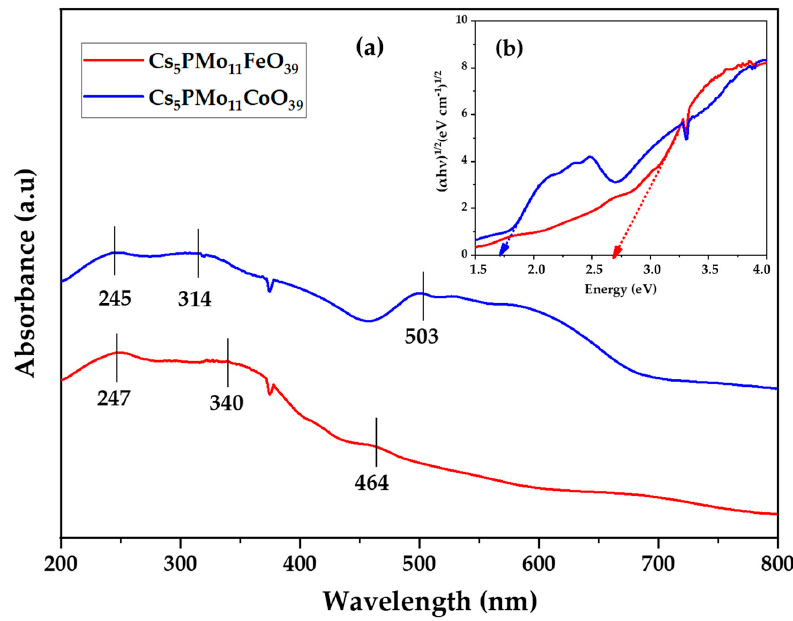
Figure 7. UV-Vis spectra in solid of Cs 5 PMo 11 FeO 39 and Cs 5 PMo 11 CoO 39 ( a ), and Tauc plot ( b ).